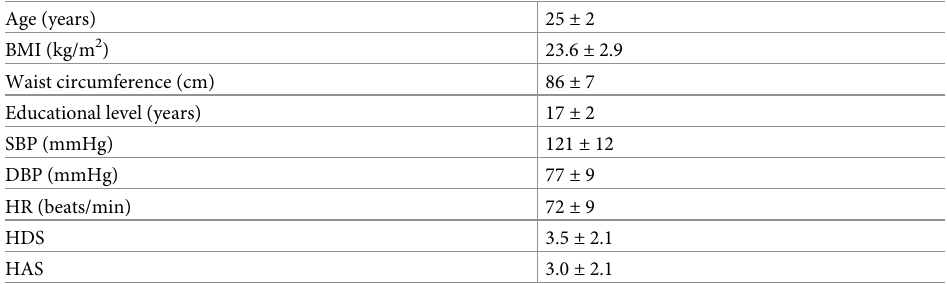
Table 1. Somatic and psychometric variables of the study population (n = 48).